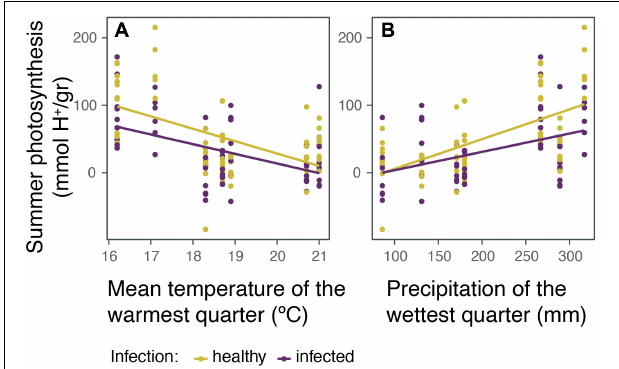
FIGURE 3 | The effect of the holoparasite Tristerix aphyllus and climatic conditions over the summer photosynthesis (mmol H+/gr) of its host Echinopsis chiloensis . Summer photosynthesis was better explained in a linear mix model (marginal R 2 = 0.5, conditional R 2 = 0.5, AICc = 1255.9) by: infection, (A) mean temperature of the warmest quarter (summer), and (B) precipitation of the wettest quarter (winter) over cactus photosynthesis. In both cases the effects are separated between healthy and infected cacti.